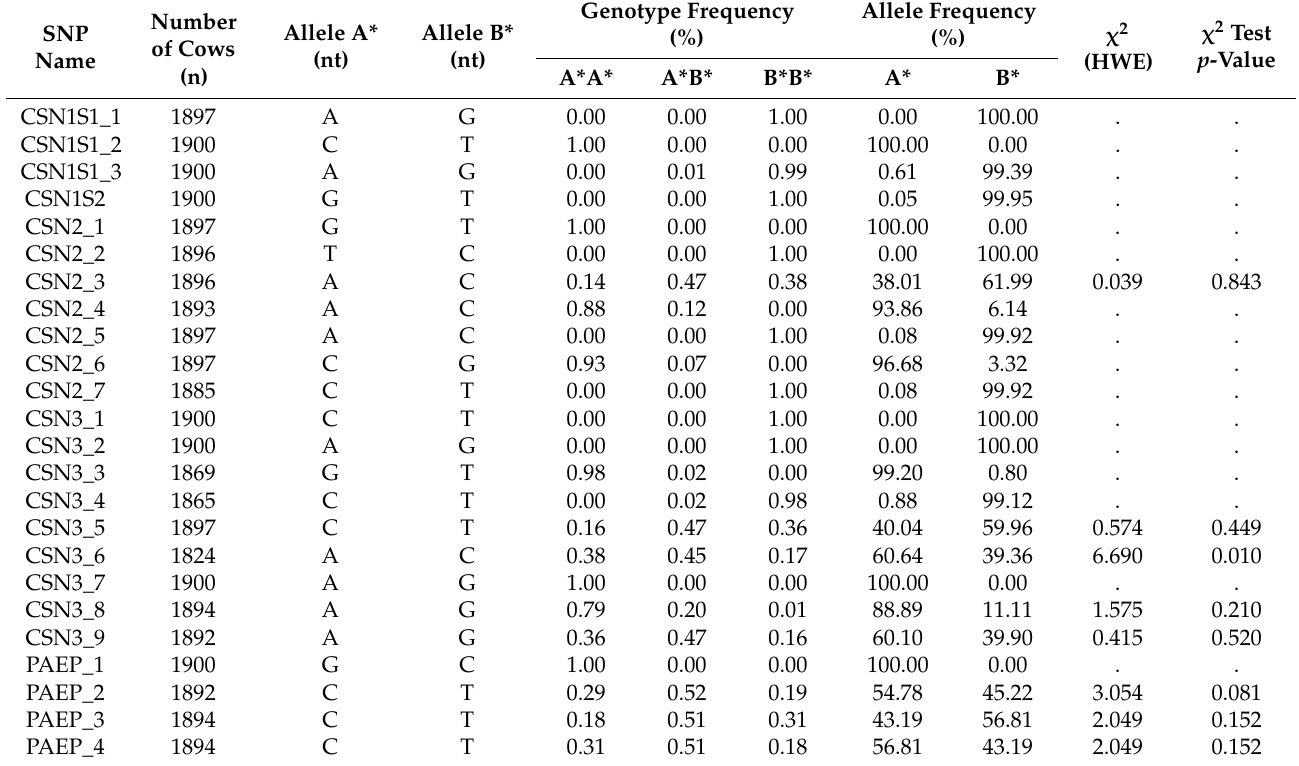
Table 2. Allele and genotype frequency (%) in tested